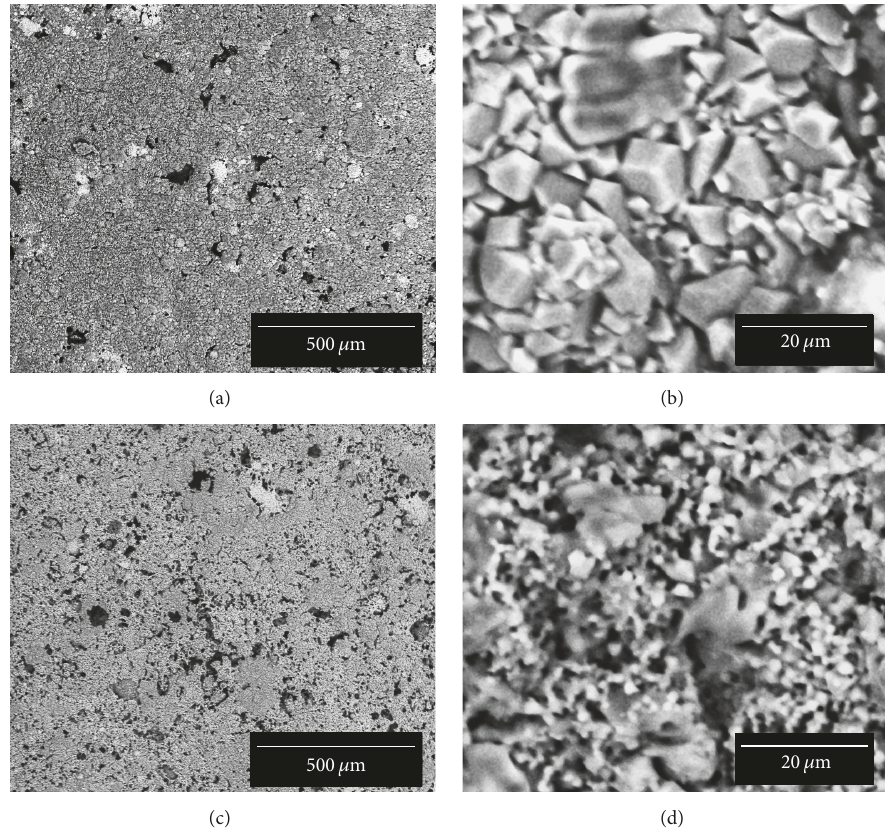
Figure 4: SEM images of the EAFD-FA mixture (a and b) as well as of the EAFD-FA-LFS mixture (c and d), both sintered at 1150 ∘ C.